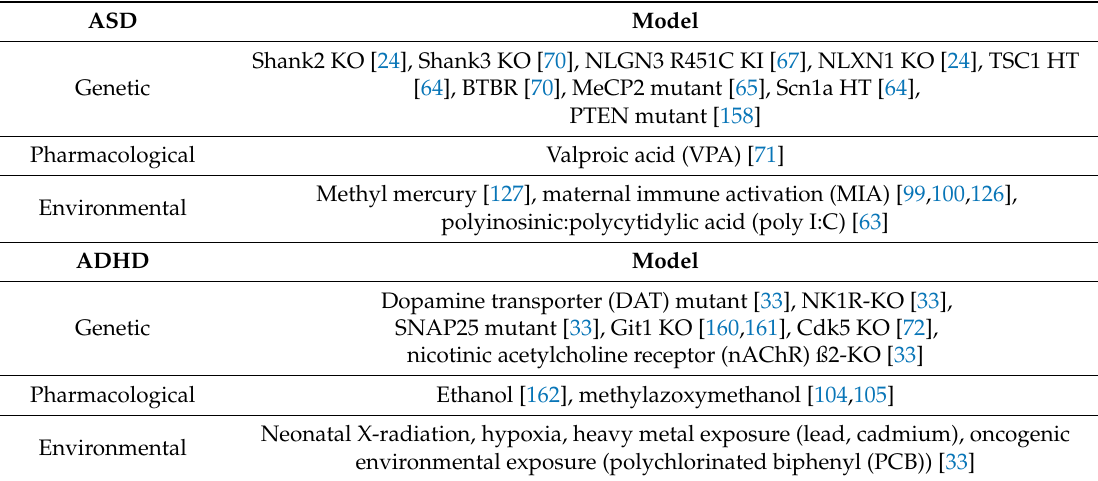
Table 2. ASD / ADHD models with observed neuron-glia interactions. ASD: autism spectrum disorder; ADHD: attention-deficit / hyperactivity